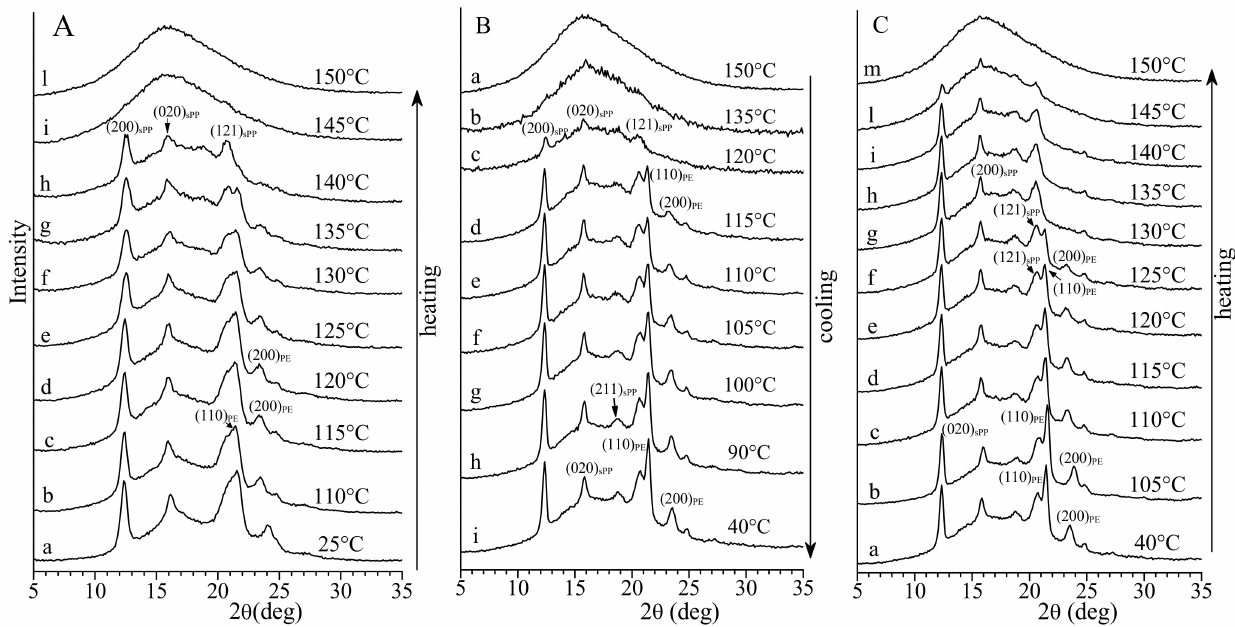
Figure 4. X-ray powder diffraction profiles of the sample PE- b -sPP with f PE = 13% recorded at different temperatures during first heating of the as-prepared sample up to the melt ( A ), during cooling from the melt to room temperature ( B ) and during successive heating of the melt-crystallized sample up to the melt ( C ). The (200) sPP , (020) sPP , (211) sPP and (121) sPP reflections of form I of sPP at 2 θ = 12.2 ◦ , 16 ◦ , 18.8 ◦ and 20.7 ◦ and the (110) PE and (200) PE reflections at 2 θ = 21.4 ◦ and 23.9 ◦ of the orthorhombic form of PE are